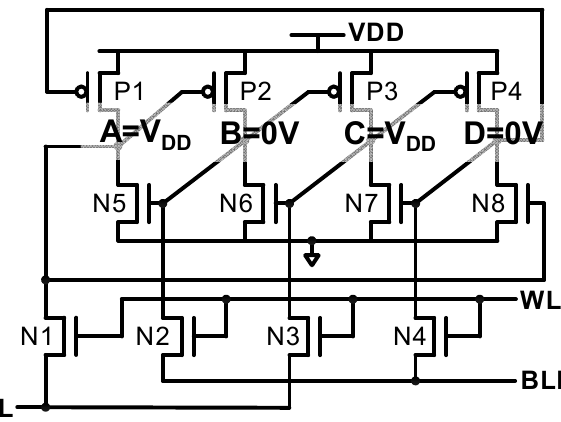
Figure 2. Schematic of 12 T DIEC SRAM cell.